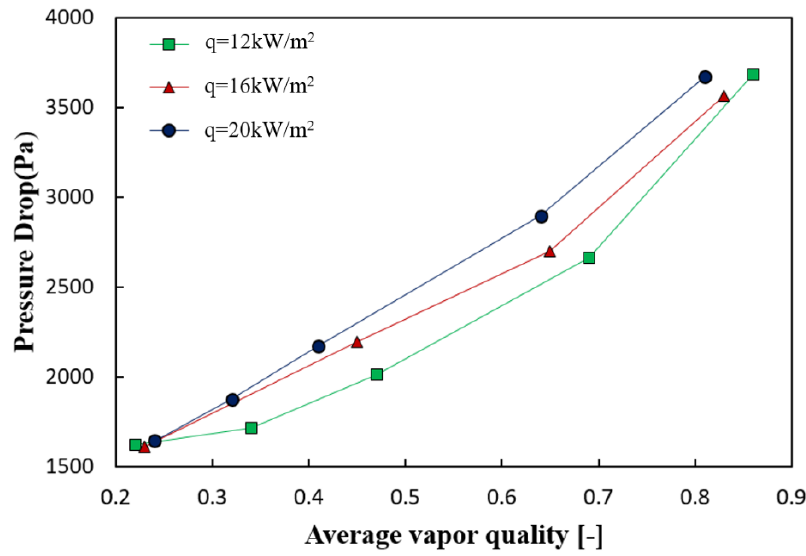
Figure 9. Pressure drop according to heat flux at various vapor quality condition.